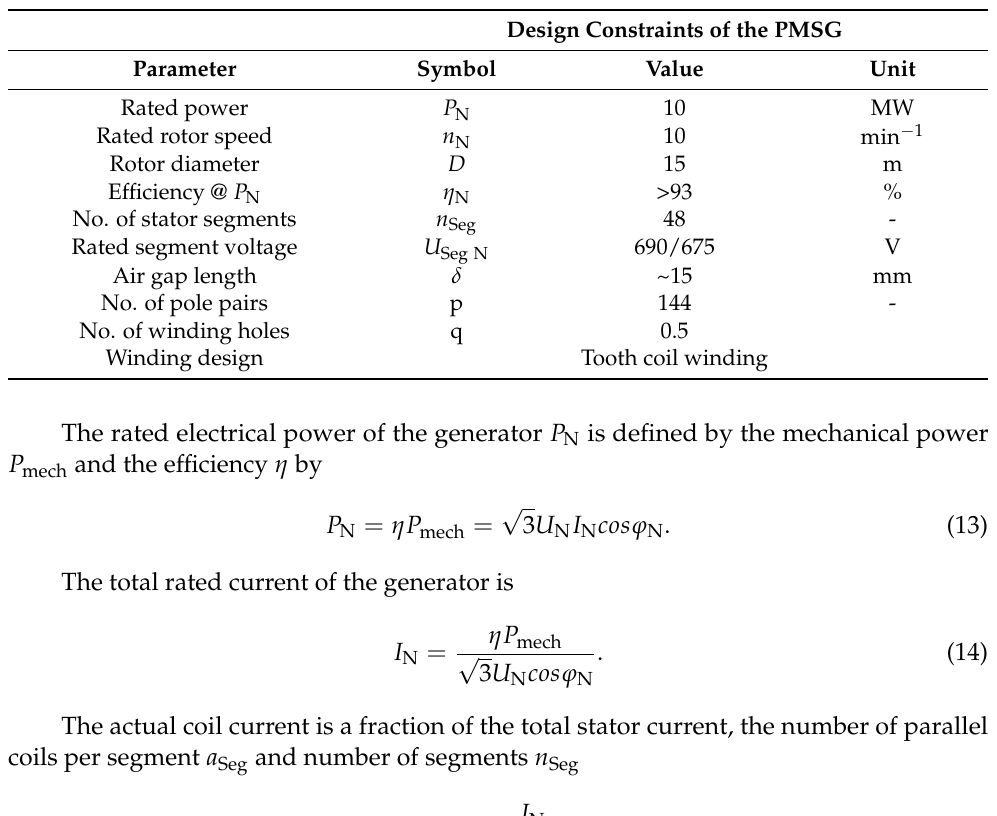
Table 2. Main Design Constraints of the